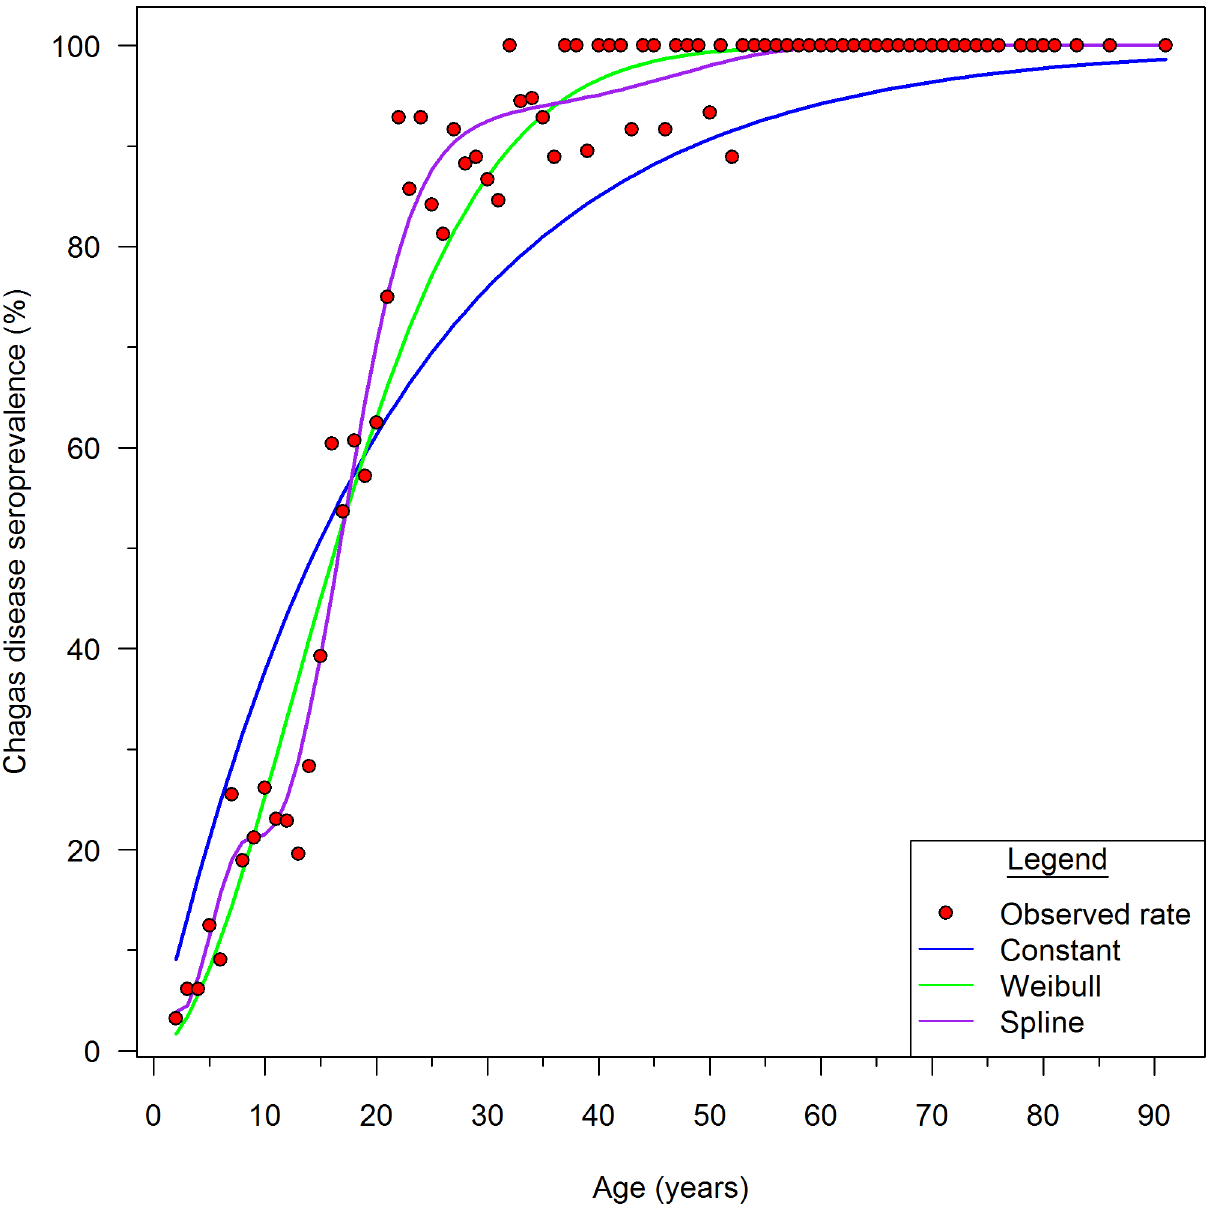
Figure 1. Actual seroprevalence and estimated seroprevalence by the three catalytic models. The scatter plot represents age-specific seroprevalence determined by serologic testing (see methods section). The solid, dashed, and dotted line are estimated seroprevalence curves using the constant, Weibull, and cubic B-spline models, respectively.